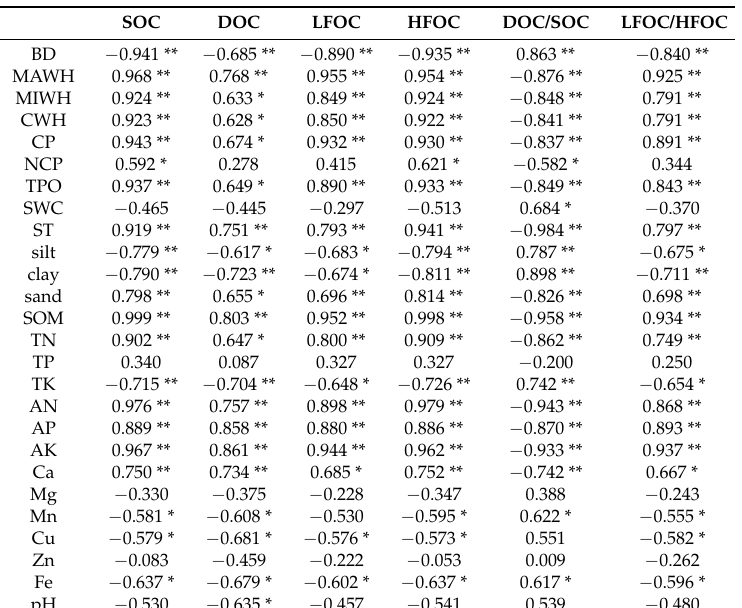
Table 2. Correlation between SOC and its fractions and soil